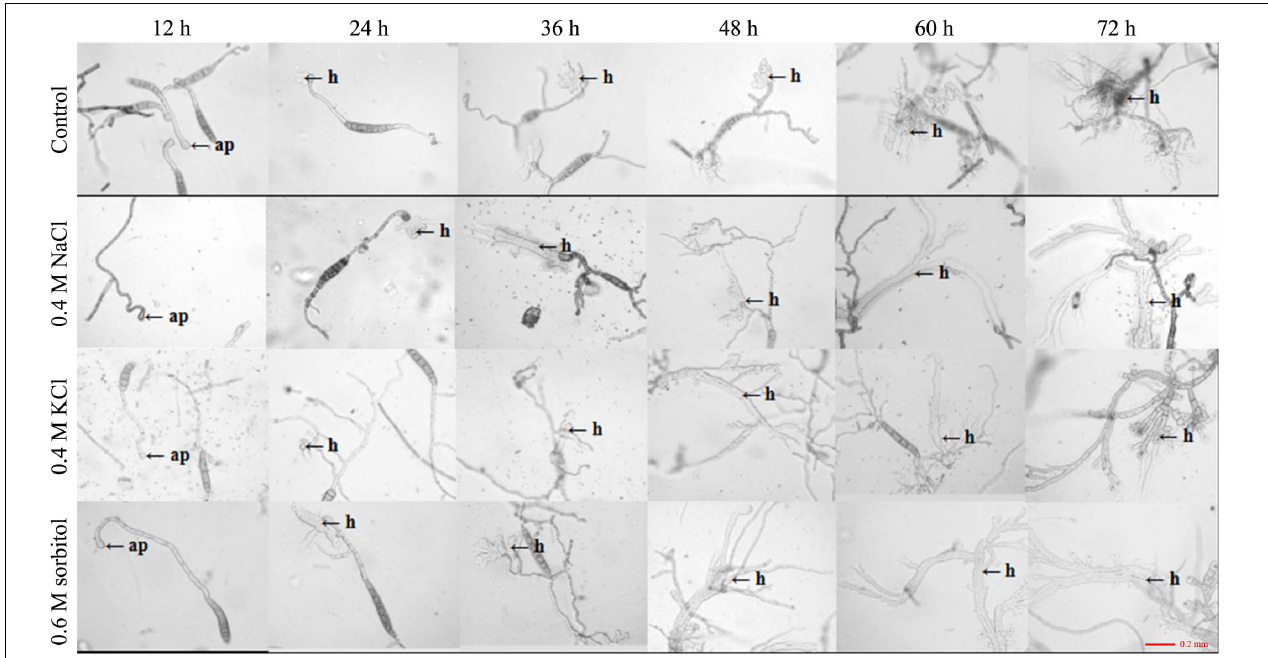
FIGURE 5 | Observation of appressorium development after 20 days of culture under the three osmotic conditions (0.4 M NaCl, 0.4 M KCl, and 0.6 M sorbitol) and control (PDA). The conidial suspension was incubated on cellophane at 25 ◦ C in the dark and observed at 12, 24, 36, 48, 60, and 72 h after inoculation under a microscope. h: invading hyphae.